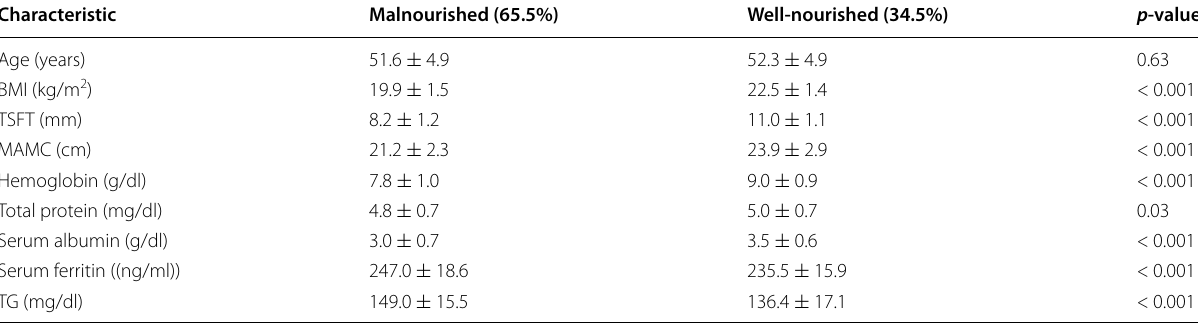
Table 3 Distribution of anthropometric and laboratory parameters between well-nourished and malnourished CKD patients with eGFR 30 ml/min/1.73 m 2 ≤